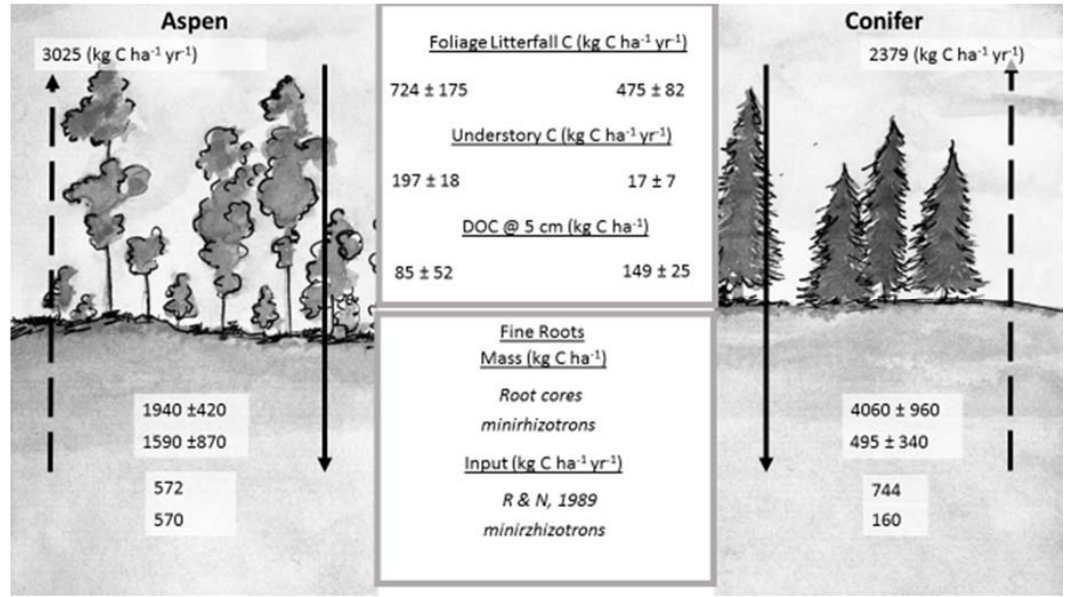
Figure 6. C fluxes into and out of soil at TWDEF. All values are averages of three plots ± SD. Foliage litterfall C is an average value for two consecutive years (2014–2016). Understory C was measured in 2015. DOC—dissolved organic carbon flux during snowmelt period averaged for three consecutive years. Fine root mass was measured from root cores and from minirhizotron data. Fine root input (R and N, 1989) was calculated using the relationships reported by Raich and Nadelhoffer [31], and using minirhizotron data evaluation. Arrows going upward indicate C loss through soil respiration with actual C loss values given on top. Soil respiration data used in the figure were originally